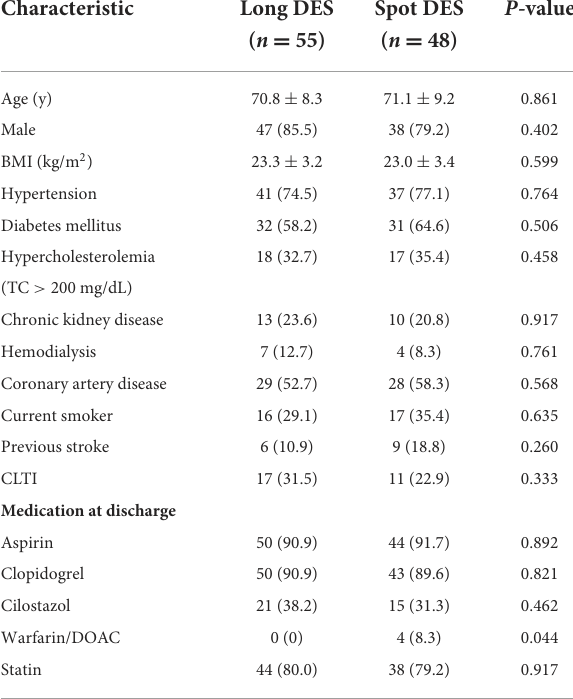
TABLE 1 Baseline clinical